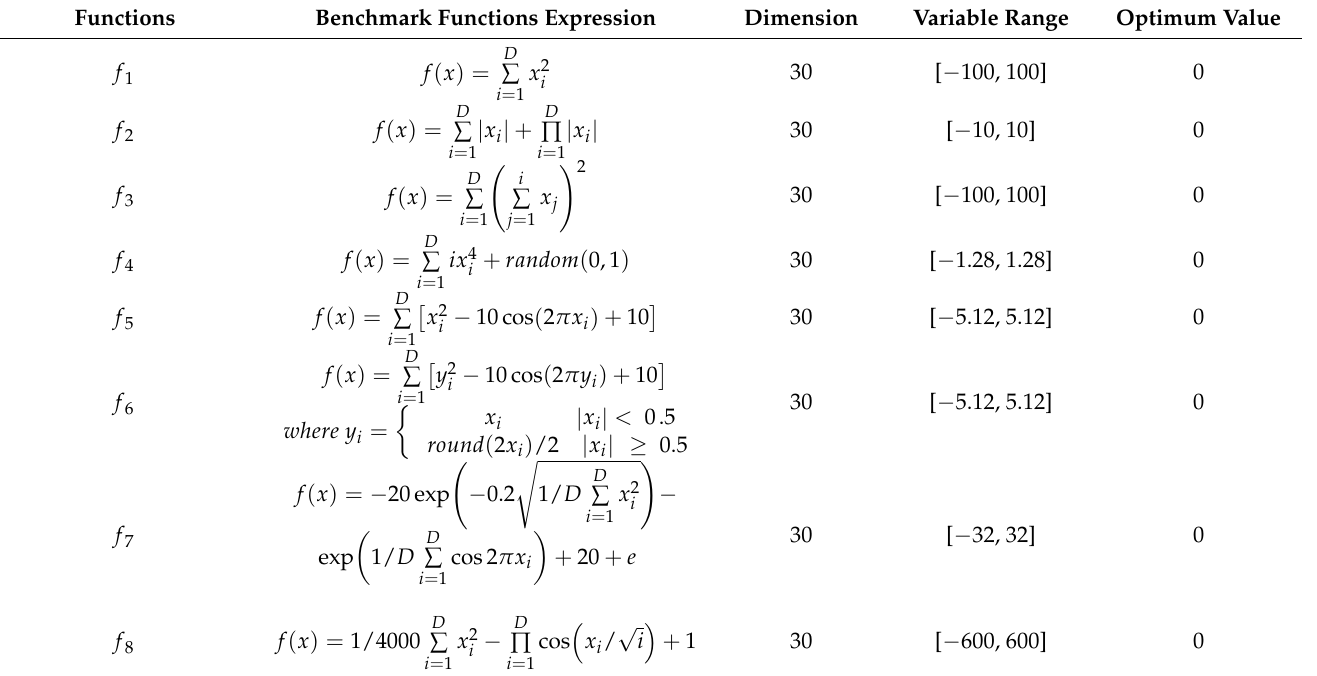
Table 2. CEC Benchmarking Functions.